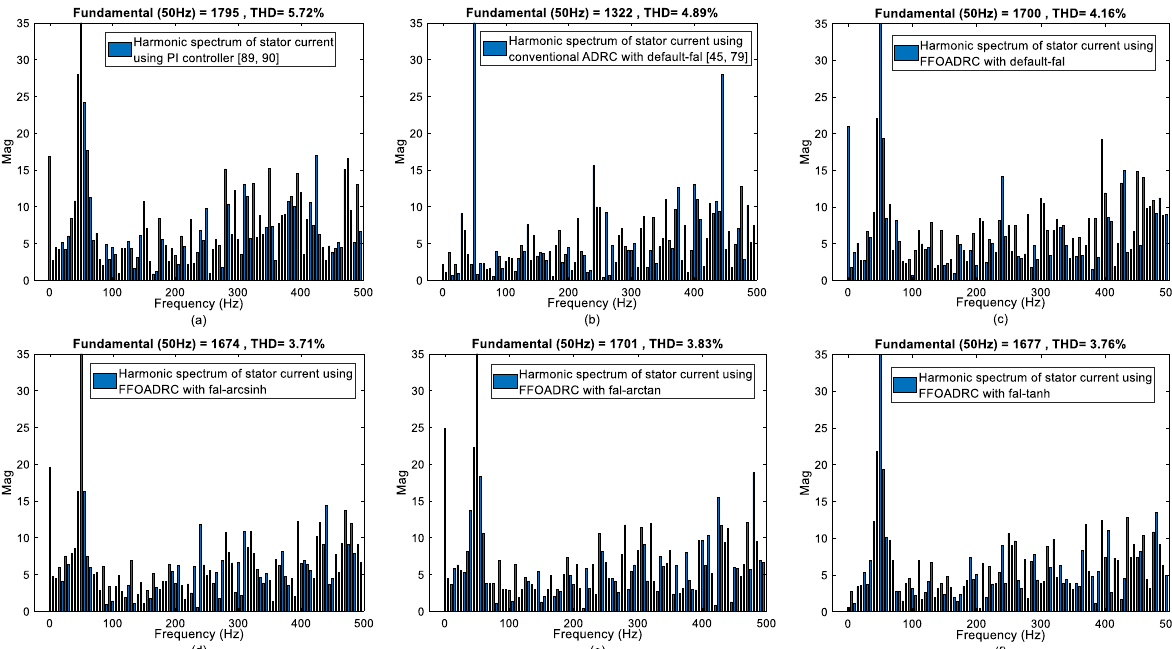
Fig. 31 Harmonic spectrum of the stator current using different controllers: ( a ) PI controller [89, 90], ( b ) Conventional ADRC with default-fal [45, 79], ( c ) FFOADRC with default-fal, ( d ) FFOADRC with fal-arcsinh, ( e ) FFOADRC with fal-arctan, and ( f ) FFOADRC with